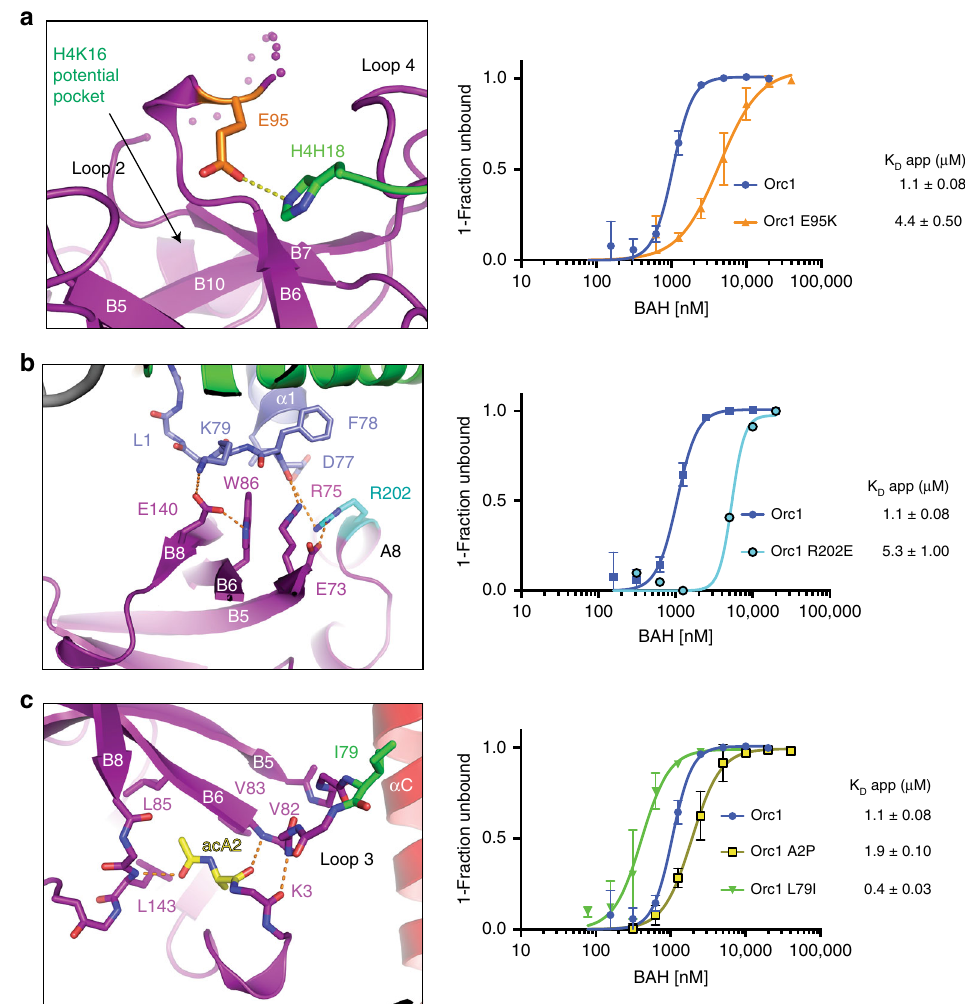
Fig. 5 Functional characterization of Orc1-nucleosome interface. a – c Structural depiction of interactions between residues in Orc1 chosen for mutagenesis and nucleosomes (left panels), and the impact of these mutations on nucleosome binding measured by EMSA (right panels). a Orc1 E95 (orange) interacts with H18 of histone H4, and mutation of this residue to lysine (E95K) results in decreased af fi nity for the nucleosome as measured by EMSA. b Orc1 R202 makes a network of interactions that contribute to the stabilization of the LRS-interacting residues. The R202E mutation decreases the af fi nity of Orc1 for the nucleosome. c Acetylation of A2 at the N-terminus of Orc1 (yellow) helps to stabilize the conformation of Loop 3, and the L79I mutation (green) increases VdW interactions of the same Loop 3. A2P mutation, which prevents acetylation of the N-terminus of Orc1, results in decreased af fi nity for nucleosome. L79I has the opposite effect, resulting in an increased af fi nity of Orc1 for the nucleosome. Each data point and error bar represent the mean ± s.d. from three independent experiments. The standard errors of dissociation constants ( K D ) are